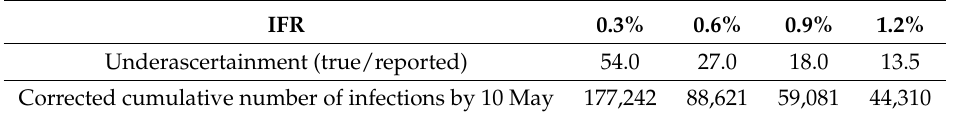
Table 7. Underascertainment (ratio of all infections to reported cases) and corrected number of cumulative cases based on the estimated